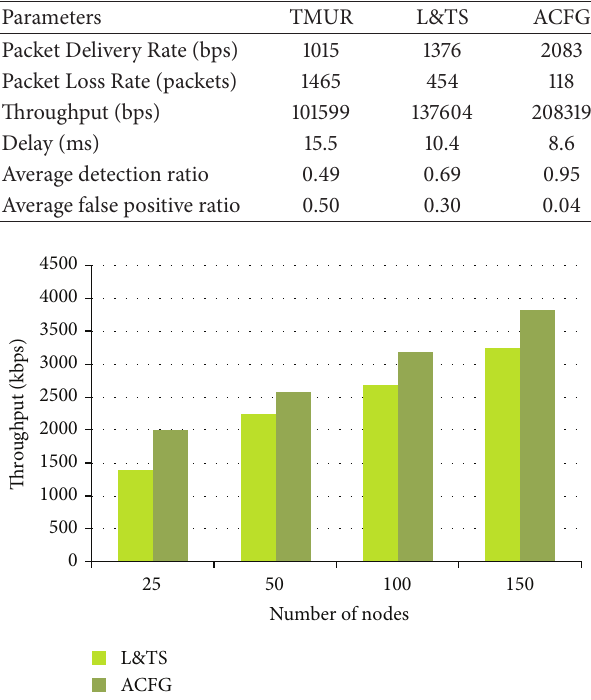
Figure 20: Throughput against number of